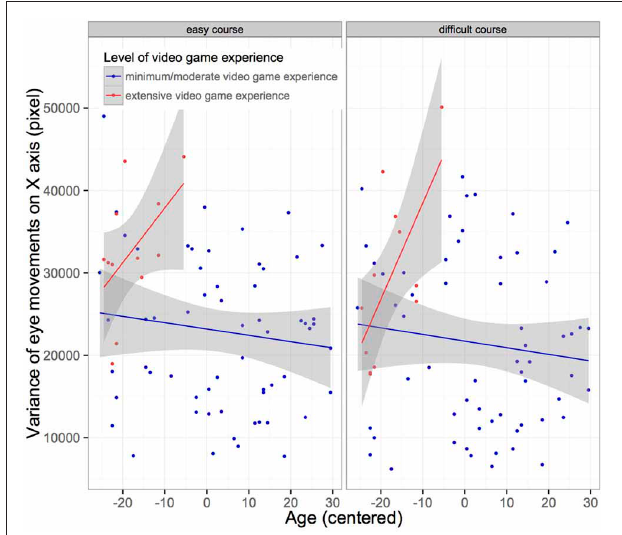
FIGURE 6 | Measure of mean variance of fixations on horizontal screen (in pixel) shown separately for both type of courses (easy vs. difficult). ( n = 73) (see Materials and Methods). Subjects that had extensive video game experience, playing video action games regularly, showed a wider distribution of fixations on the X -axis of the screen. These subjects were of younger age. There were no elderly participants with extensive video game